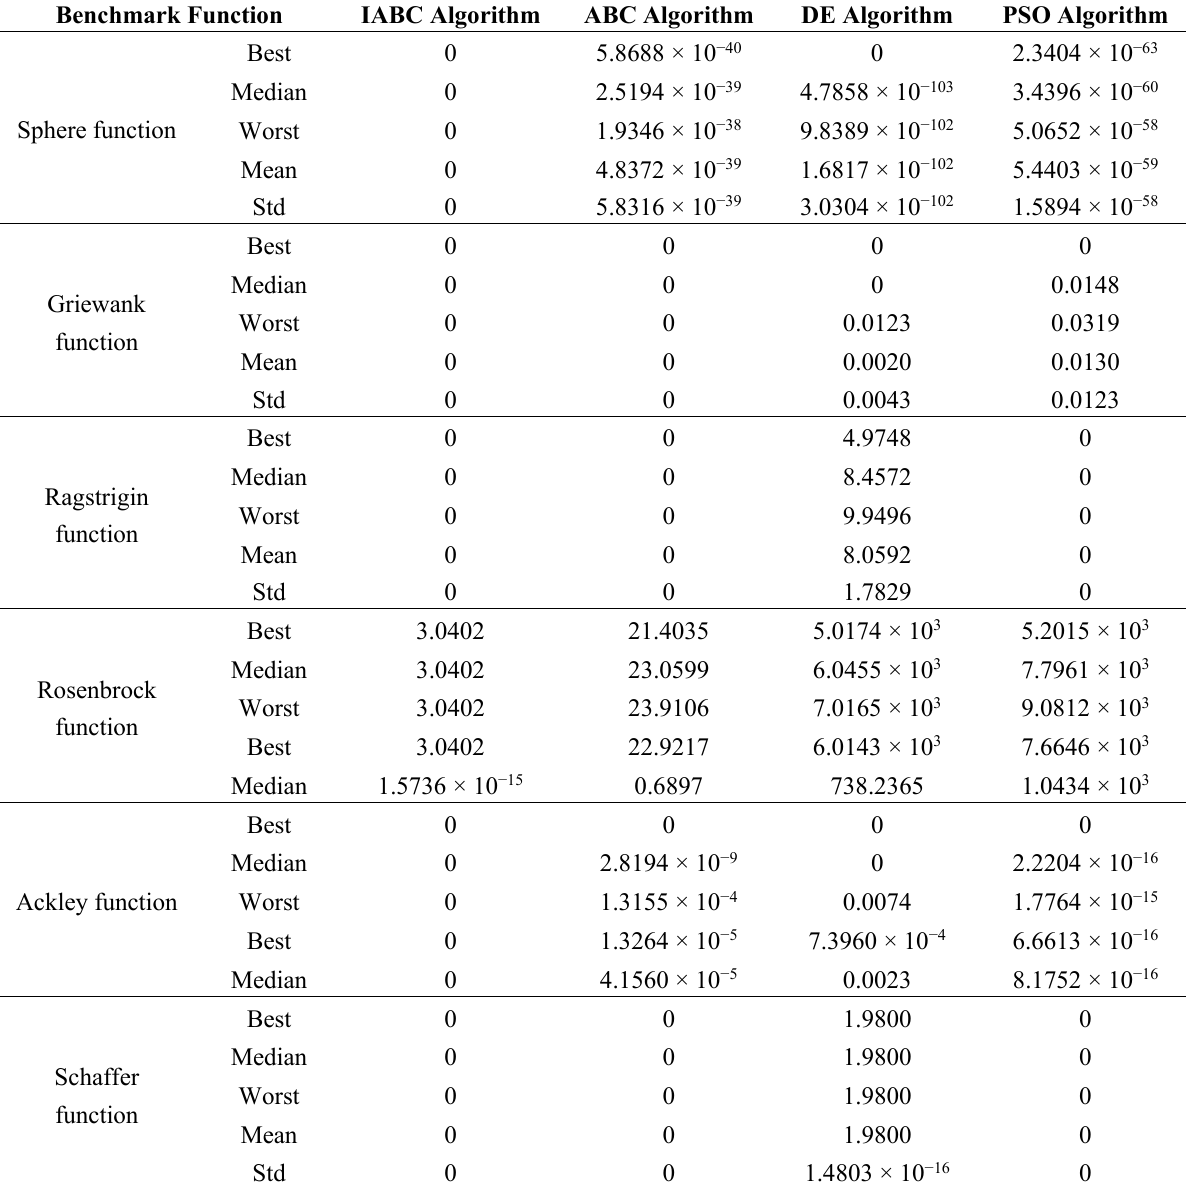
Table 3. Comparison of testing result of different optimization